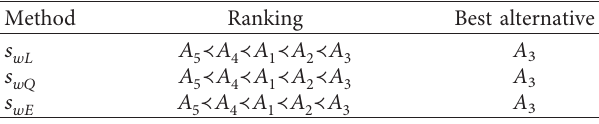
Table 5: Ranking order of alternatives for different similarity